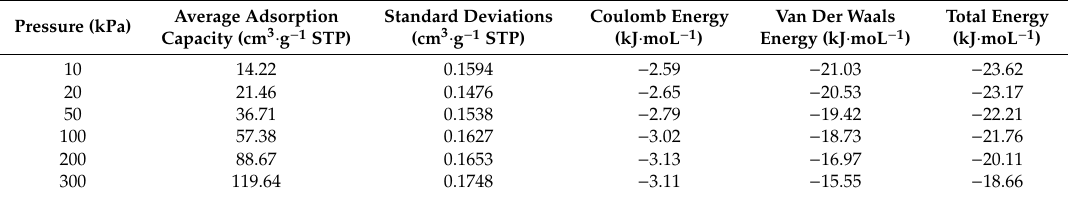
Table 5. The adsorption capacities and adsorption energies of CO 2 on MIL-101 (Cr) under di ff erent pressures at 298 K.